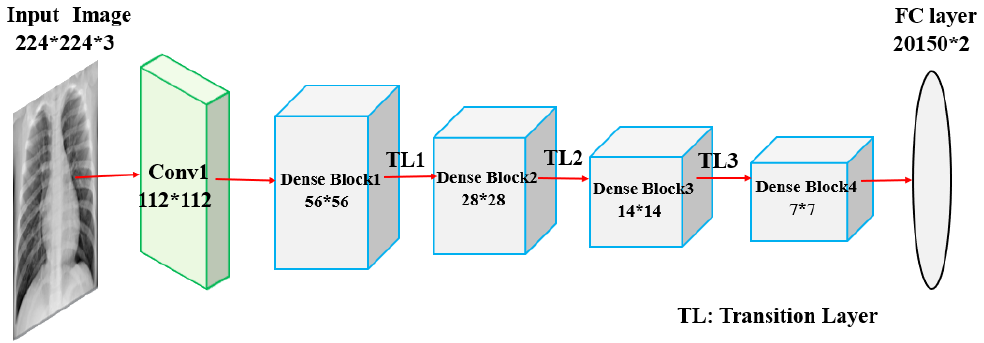
Figure A2. Densenet121 architecture with the convolutional (112*112) layer at the beginning and five dense